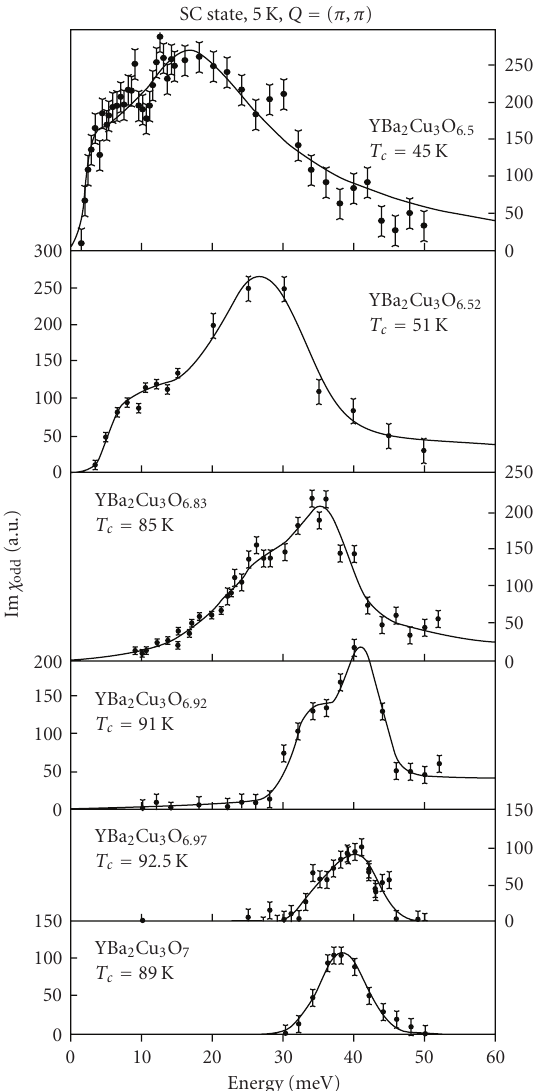
Figure 3: Magnetic spectral function Im χ ( − ) ( k , ω ) in the supercon- ducting state of YBa 2 Cu 3 O 6+ x at T = 5K and at Q = ( π , π ). 100 counts in the vertical scale correspond to χ ( − )